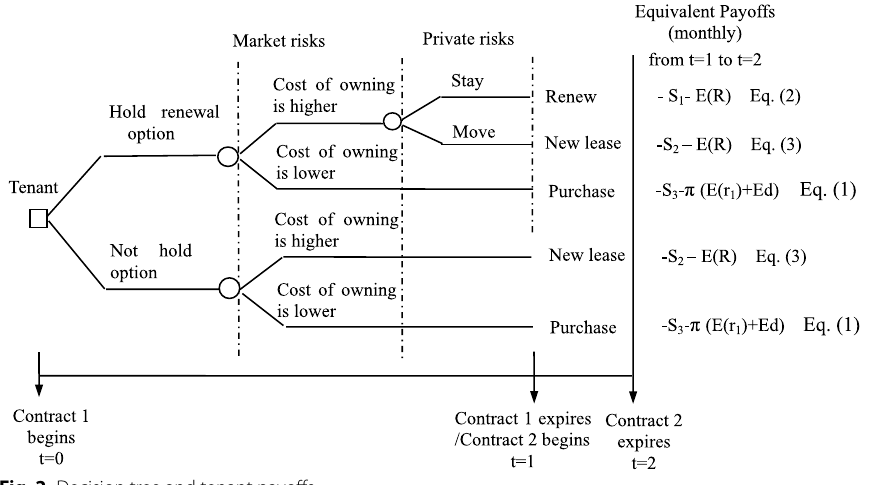
Fig. 2 Decision tree and tenant